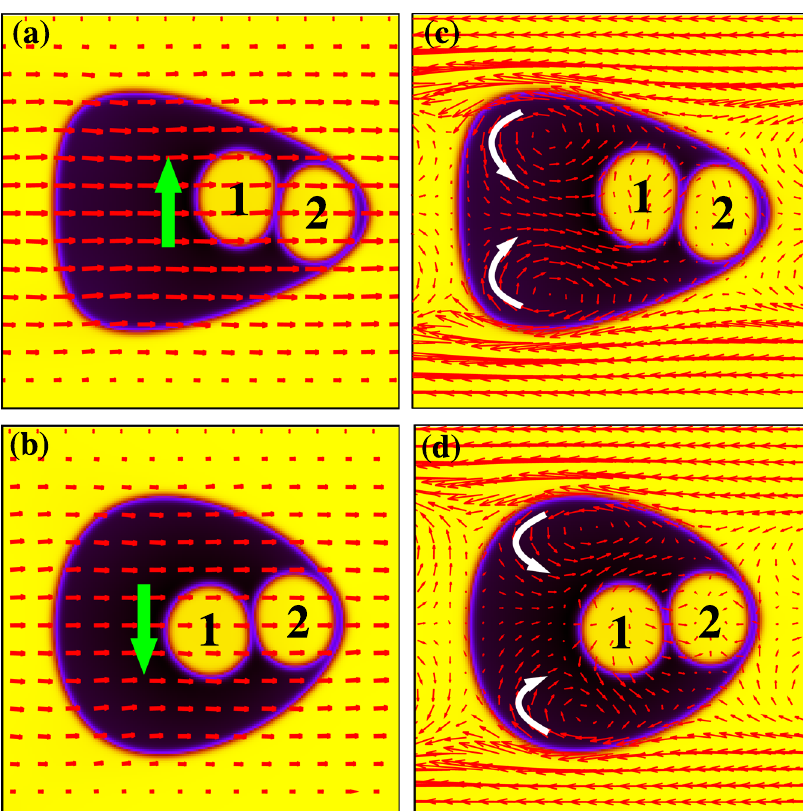
Fig. 4 Onset of periodic motion in a two-core emulsion. In a – c Re ’ 3 and Ca ≃ 0.52, while in b – d Re ’ 1 : 2 and Ca ≃ 0.2. Red arrows indicate the direction of the fl uid fl ow in the lab frame ( a and b ), and in the external droplet frame ( c and d ). Green arrows in a and b denote the direction, perpendicular to the fl ow, along which the droplet 1 starts its motion, while white arrows in c and d bespeak the direction of the fl uid